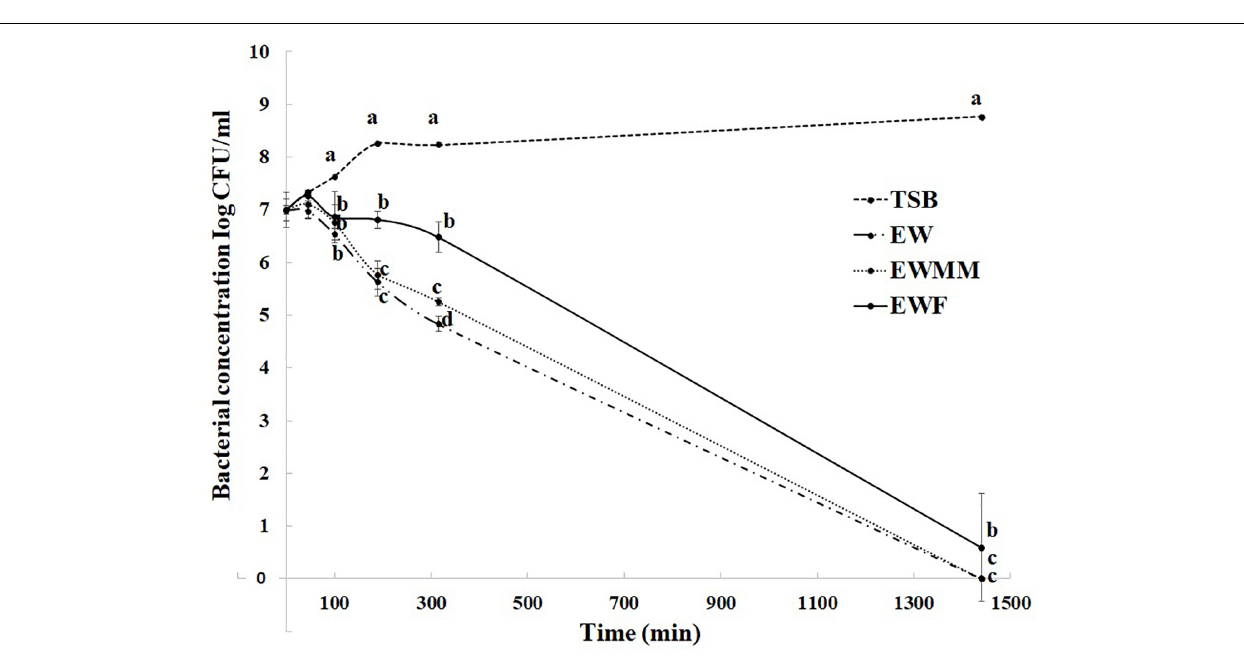
FIGURE 2 | Survival curves of S. Enteritidis in EW media at 45 ◦ C. Media employed were TSB (control), EW, EWF (free of EW proteins of > 10 kDa), and EWMM (EWF with 10% EW). Means of triplicate experiments are shown with standard deviations. For each time, results between media were compared using analysis of variance and the average comparison test using the R software. Letters were used to identify averages that are significantly different ( p ≤